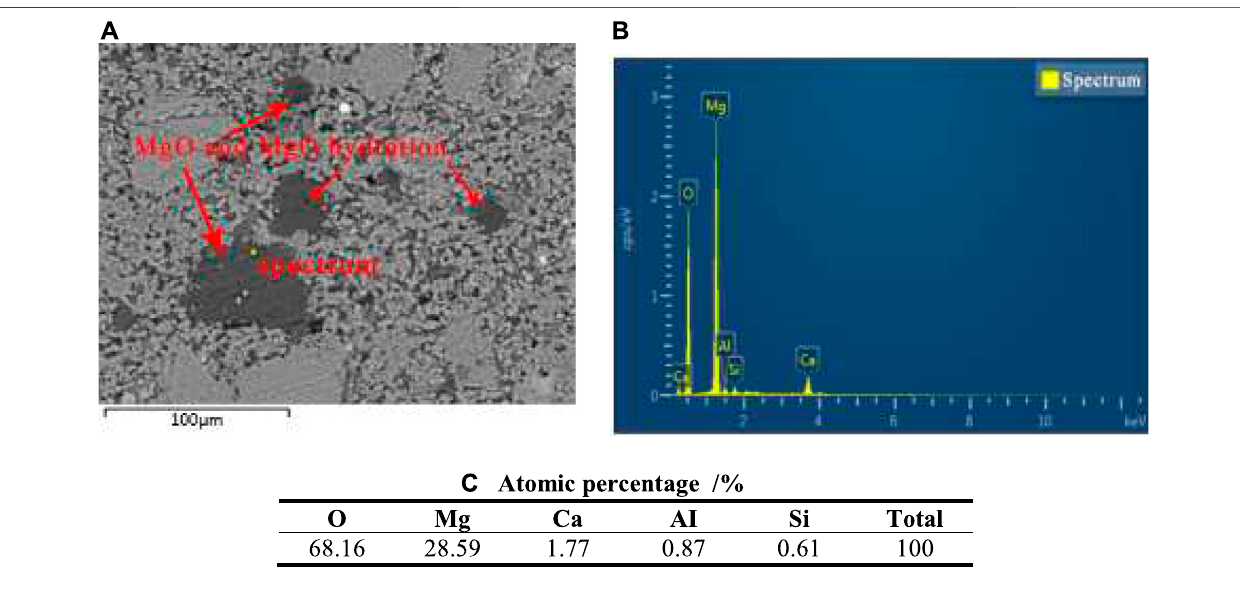
Frontiers in Materials |